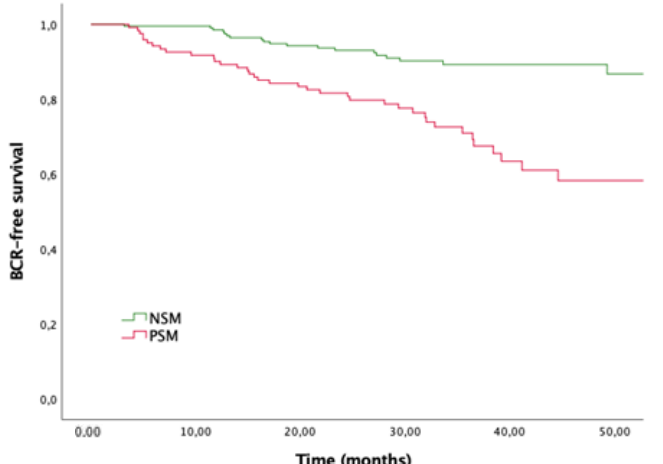
Figure 1. Kaplan-Meier curves for biochemical-recurrence stratified by margin’s status. Log-rank p < 0.001.